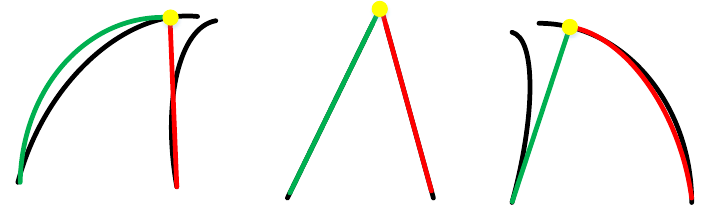
Figure 3. Road model.